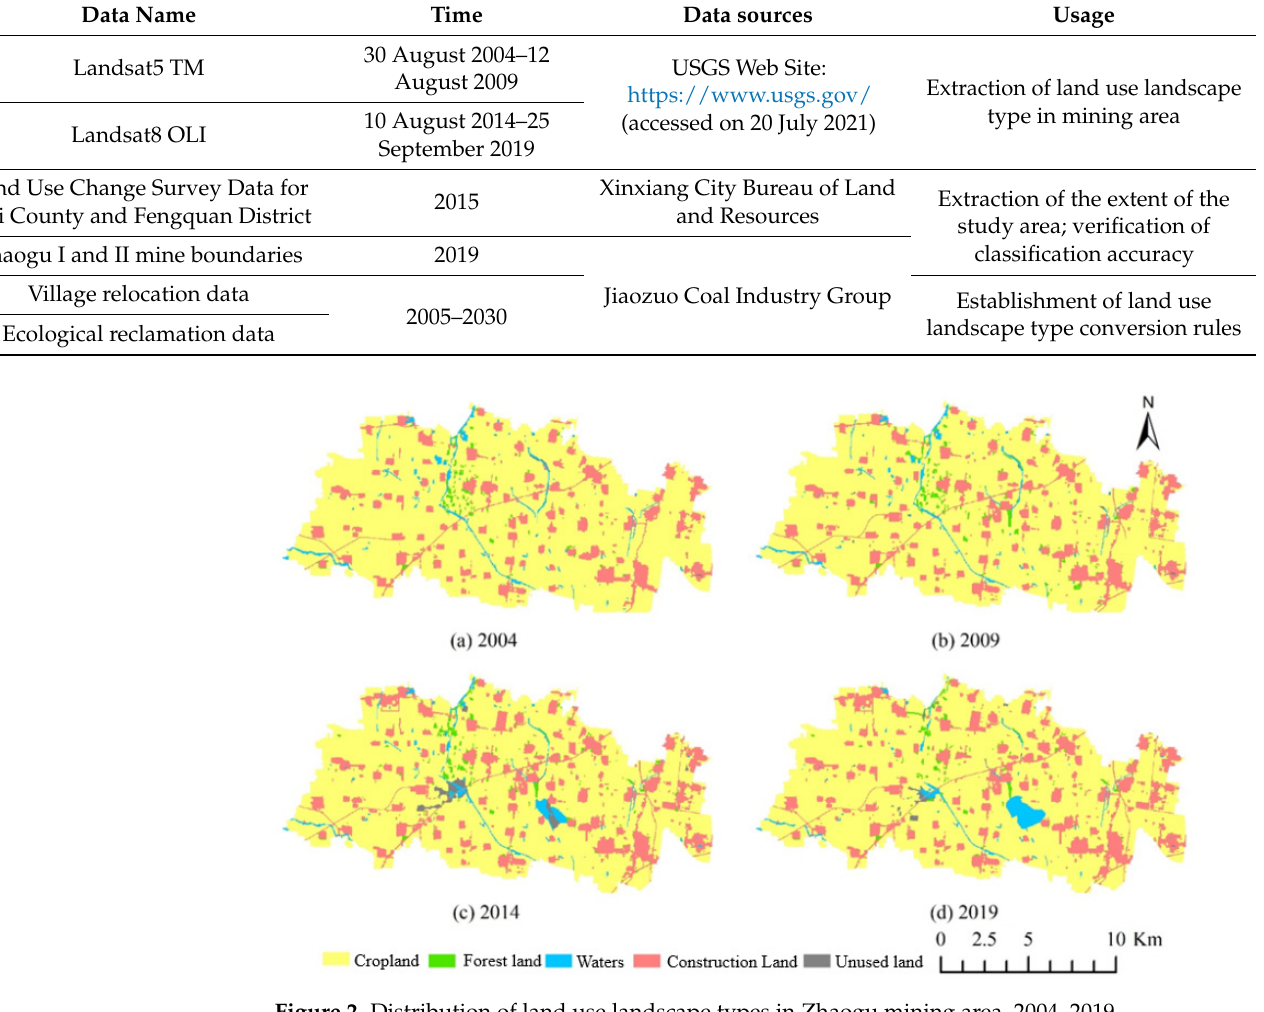
Figure 2. Distribution of land use landscape types in Zhaogu mining area, 2004–2019.